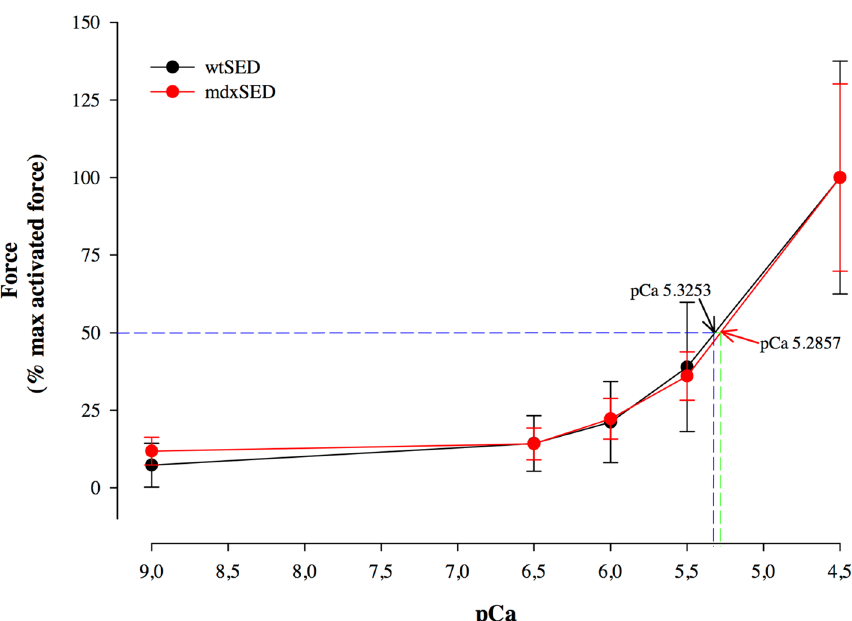
Figure 6. Force-pCa 2+ relation for the wt SED and the mdx SED groups. There was no difference in Ca 2+ sensitivity, as the value for pCa 50 was not different between the control (mean 5.35 ± 0.08) and mdx (mean 5.41; ± 0.13) groups. Abbreviations: wild-type Sedentary group ( wt SED); mdx Sedentary group ( mdx